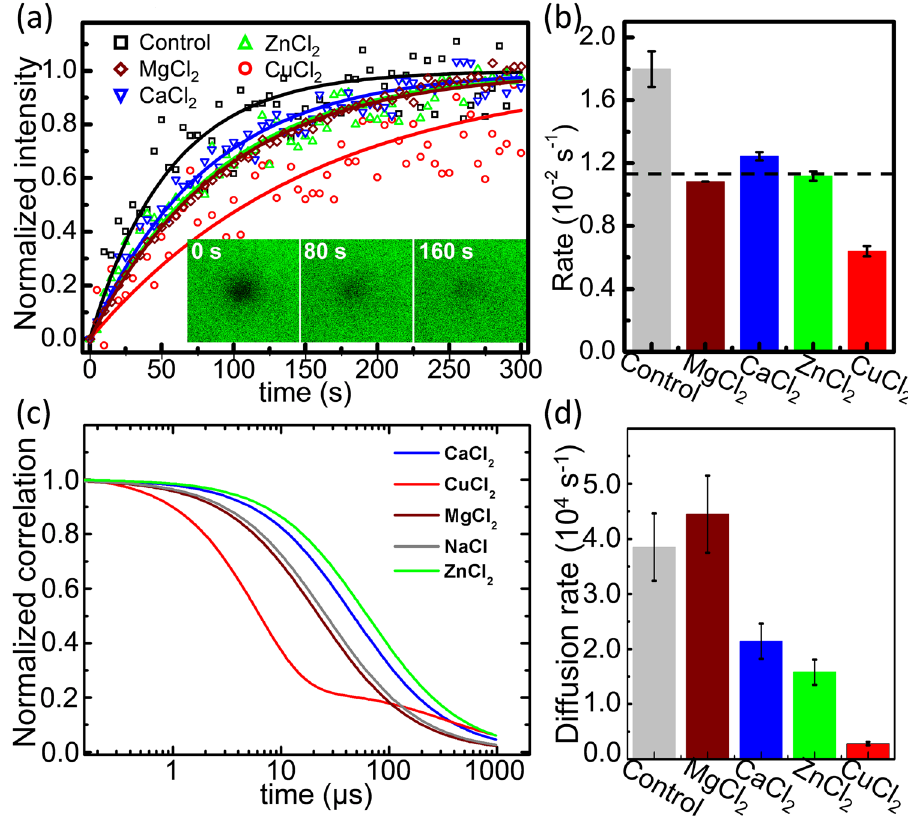
Figure 1. Fluidity of a lipid bilayer in the presence of metal ions. ( a ) Normalized fluorescence intensity. The red circle, green triangle, blue inverted triangle, wine diamond and black rectangle indicate the fluorescence data with incubation of Cu 2 + , Zn 2 + , Ca 2 + , Mg 2 + and control (Na + ), respectively. The data are fitted with the curves with corresponding colors. The insets are the fluorescence-recovery images with incubation of Cu 2 + at the times 0 s, 80 s and 160 s. ( b ) Rates of fluorescence recovery. The rate of incubation with CuCl 2 is obviously less than those with other buffers, while the rates with MgCl 2 , CaCl 2 and ZnCl 2 are comparable (black dashed line). ( c ) FCS correlation curves under different metal ions. Expect for copper ions, which is fitted with the second model containing the triplet decay, others are by 2D membrane-localized model. Each curve is the global fitting result from at least three trajectories in different measurements. The correlation factors are normalized at τ = 0. ( d ). Diffusion rates of lipid calculated by FCS under different metal ions. Actually, k D = τ D − 1 = 4 D/s 2 , while s is the radius of the focus and D is the mean diffusion coefficient of